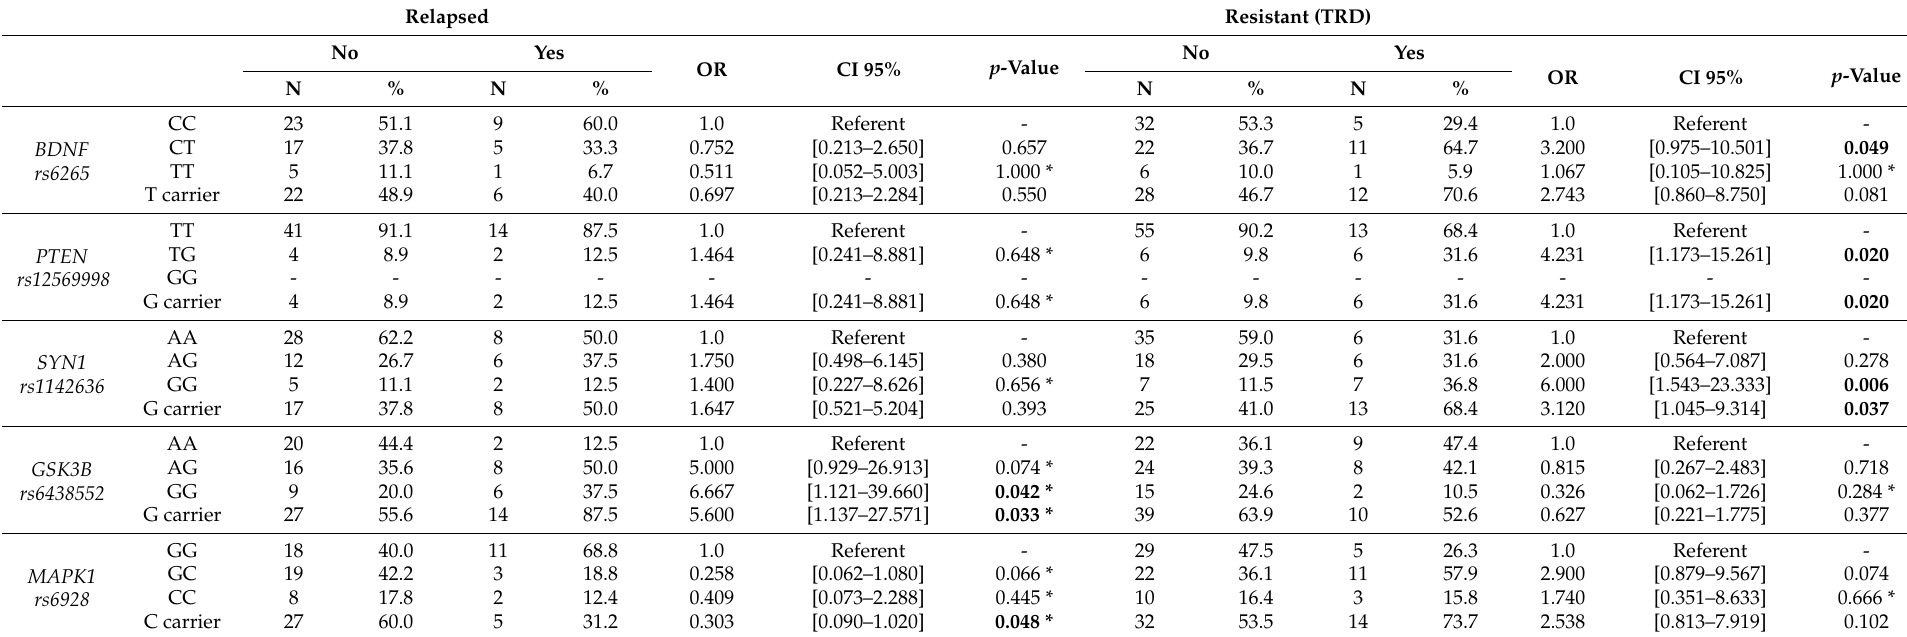
Table 1. Association between genotypes frequencies from the most relevant polymorphisms and AD treatment